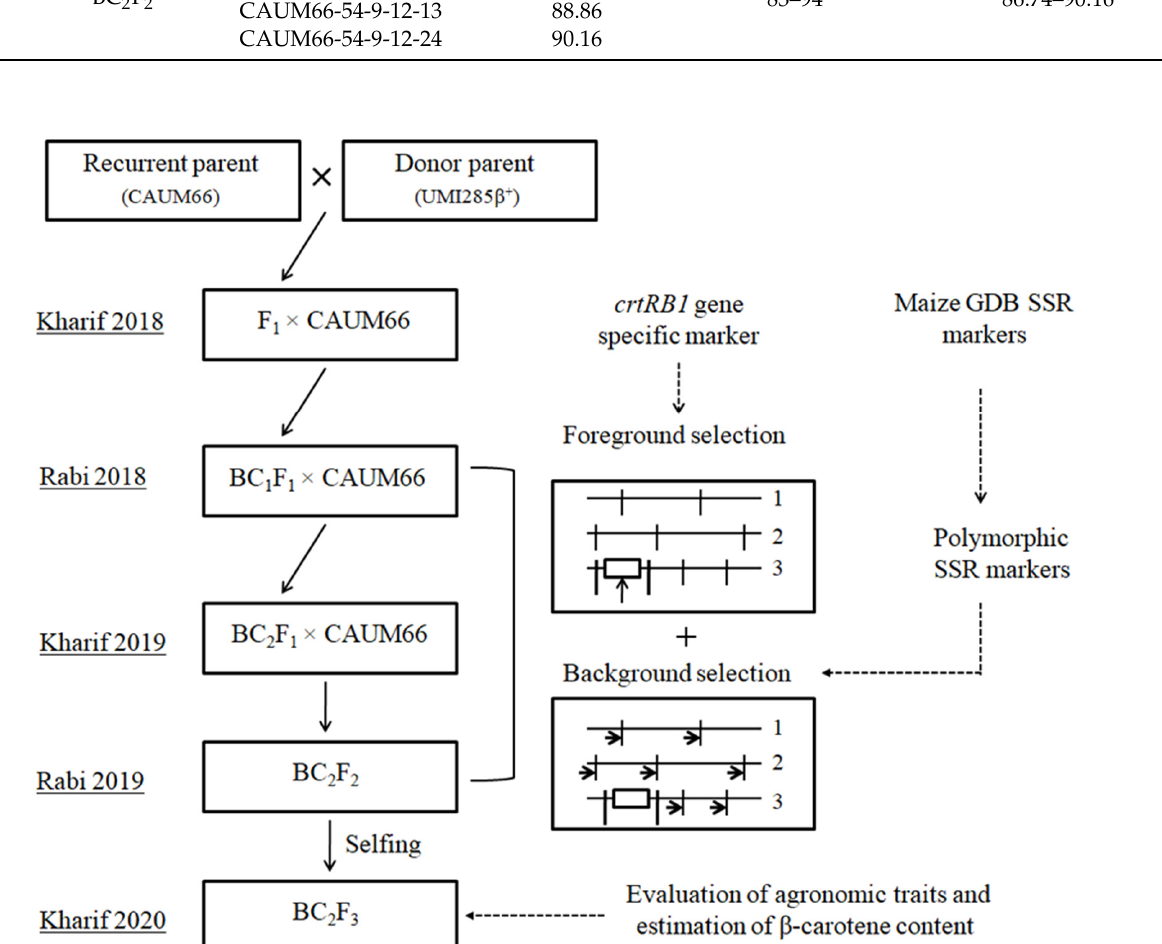
Figure 1. Scheme of marker-assisted backcross breeding (MABC) to improve the β-carotene content in CAUM66.